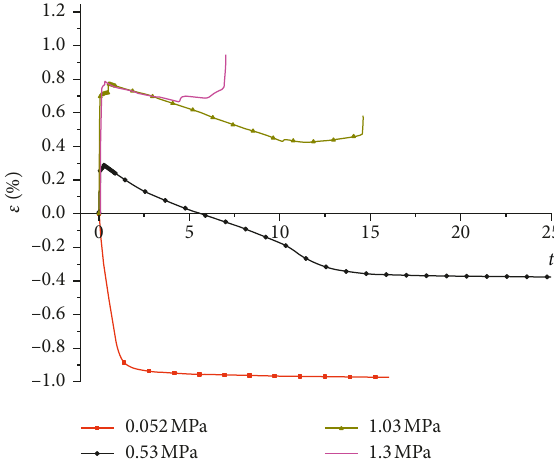
Figure 6: Relationship between swelling stress and time under different stress levels.